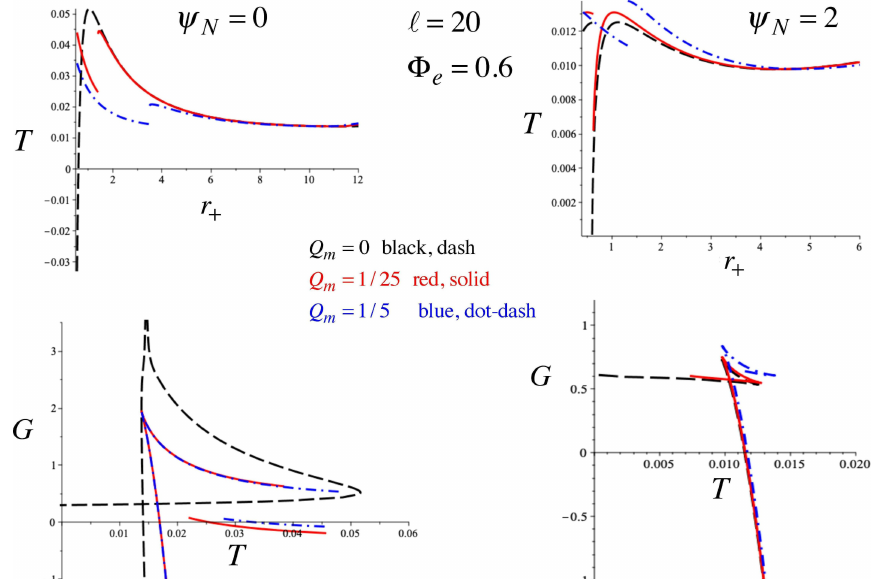
Figure 15 . Case 1(b) Fixed Electric and Magnetic Charges. The plots on the left are for temper- ature and free energy for fixed ψ ( I ) = 0 , and on the right for fixed ψ ( I ) = 2 , and for the respective N N fixed horizon magnetic charges shown. The fixed electric charge Q e = 0 . 6 , and ‘ = 20 . The presence of magnetic charge induces a discontinuity in the free energy, but this is restored for sufficiently large ψ ( I ) N